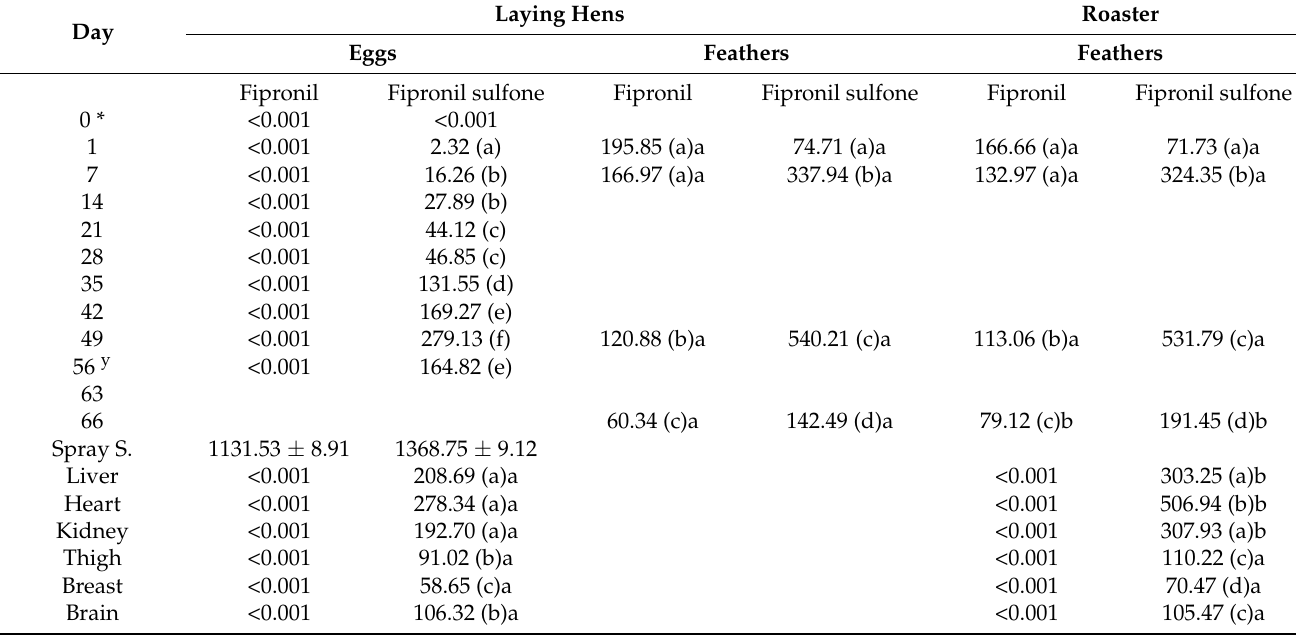
Table 4. Concentrations of fipronil and fipronil sulfone (mg/kg) in the samples from the air spraying (trial